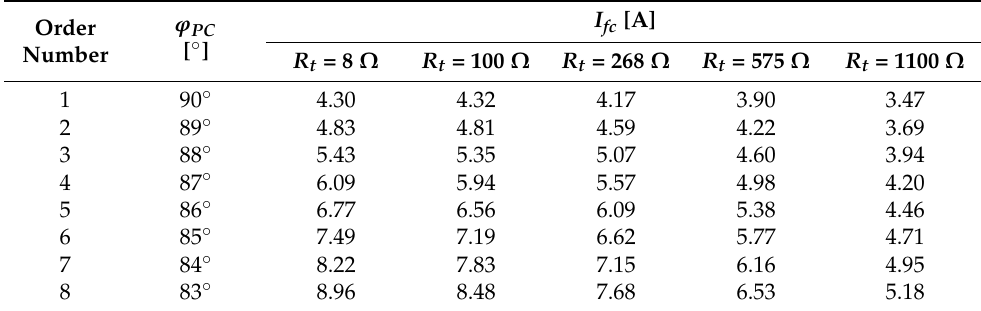
Table 7. Effective value of the fault current depending on ϕ PC , when ϕ c = 87 ◦ .